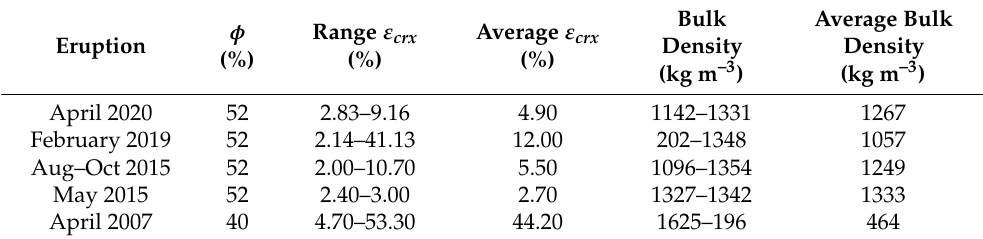
Table 1. Summary of petrologic method data used to estimate the sulfur content and SO 2 mass, where ε crx is the crystalinity and φ the vesicularity (http://wwwobs.univ-bpclermont.fr/SO/televolc/ dynvolc/ (last access: 14 June